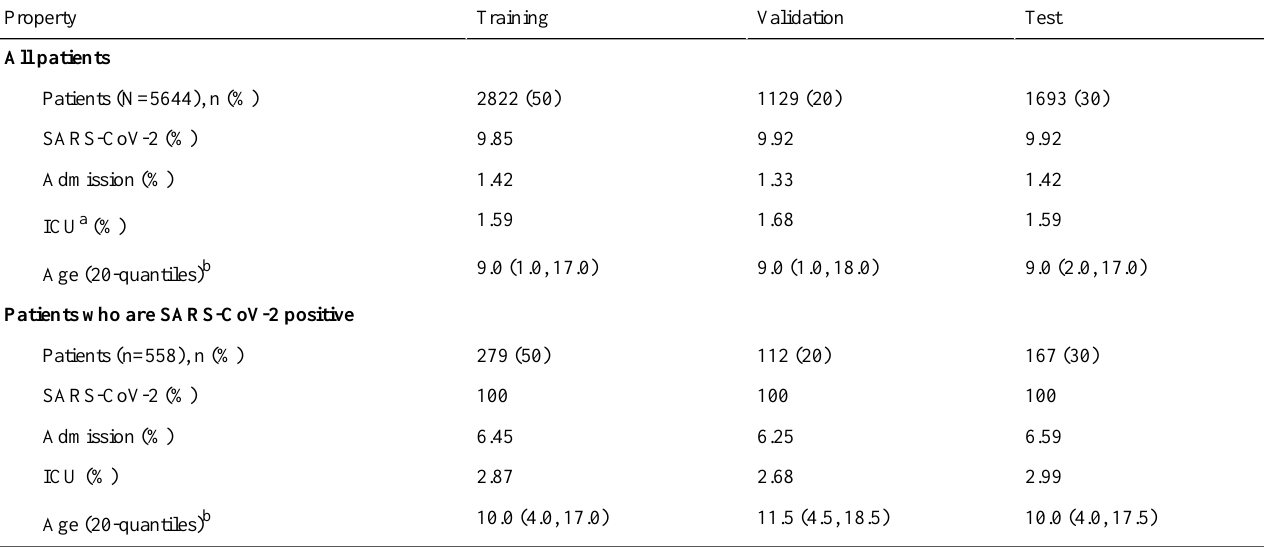
Table 1. Training, validation, and test fold statistics for all patients and patients who are SARS-CoV-2 positive.